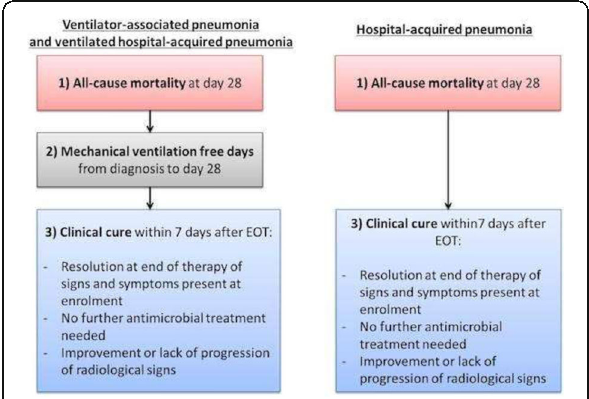
Fig. 1 (abstract 0019). Final hierarchical composite endpoint